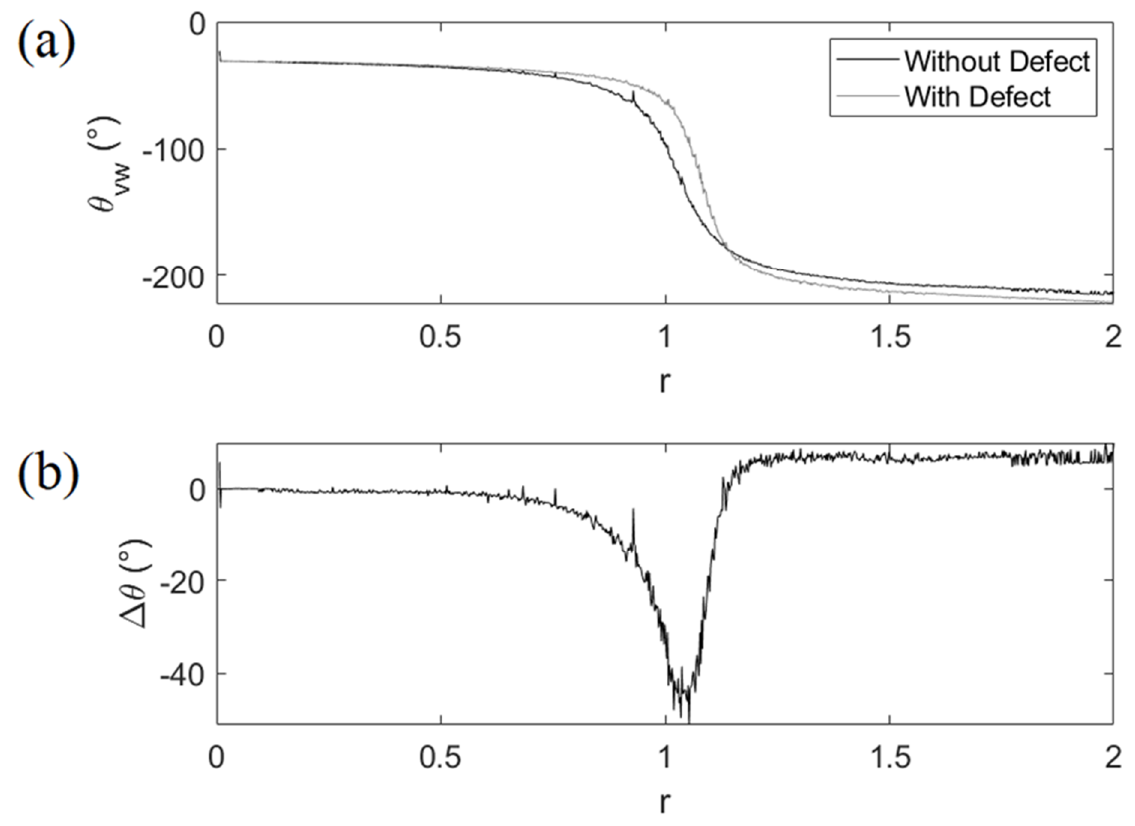
Figure 7. ( a ) Phase difference between rods 2 and 3, (cid:2016) (cid:3049)(cid:3050) , with and without defect. ( b ) Measured ∆(cid:2016) = (cid:2016) (cid:3049)(cid:3050) (defected) − (cid:2016) (cid:3049)(cid:3050) (undefected) as a function of driving parameter (cid:1870) . ∆ θ = θ vw ( defected ) − θ vw ( undefected ) as a function of driving parameter r